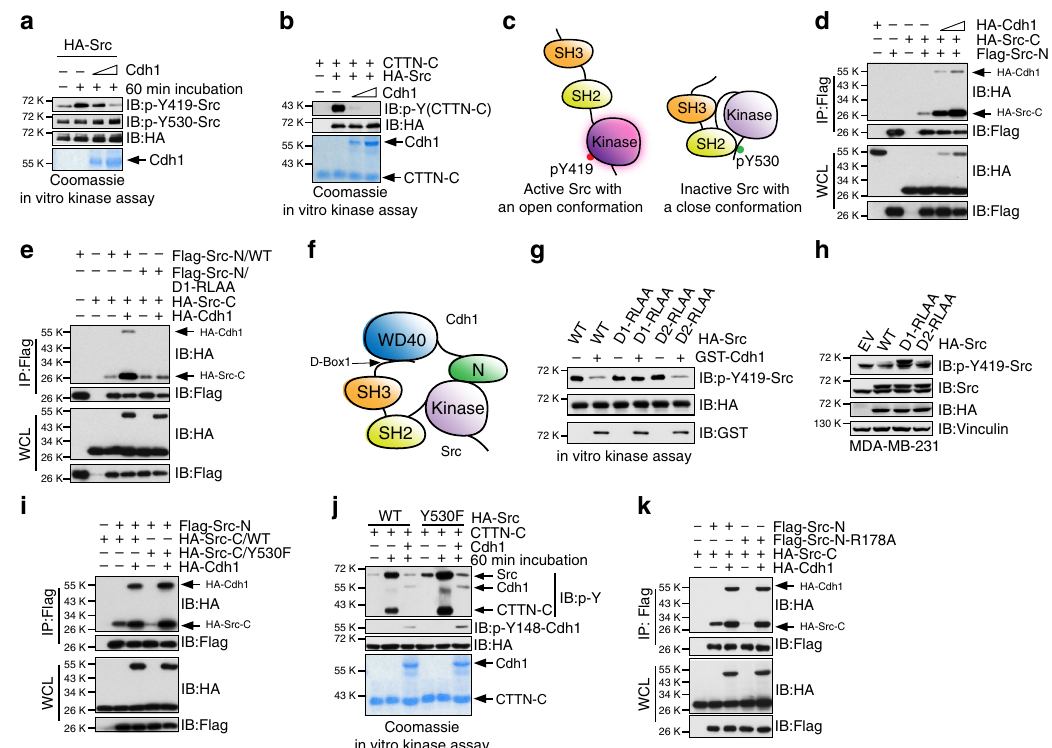
Fig. 4 Cdh1 suppresses Src kinase activity by locking Src in a closed conformation. a Immuno-puri fi ed HA-Src from 293T cells were incubated with bacterially puri fi ed and cleaved recombinant Cdh1 as indicated. The reaction was performed at 30 °C for 60 min followed by SDS-PAGE and Immunoblot (IB) analyses. b Recombinant Cdh1 inhibited the kinase activity of Src to promote the C-terminal domain of p85 cortactin (CTTN- C ) phosphorylation in vitro. c A schematic illustration of the open and closed conformations of the Src kinase. d IB analysis of whole-cell lysates (WCL) and immunoprecipitates (IP) derived from 293T cells transfected with HA-Cdh1 and the indicated Src constructs. e IB analysis of WCL and IP derived from 293T cells transfected with HA-Cdh1 and the indicated Src constructs. f A schematic illustration of how Cdh1 secures the closed, inhibitory conformation of Src by reinforcing the binding between N - and C - terminus of Src. g Immuno-puri fi ed HA-Src proteins from 293T cells were incubated with bacterially puri fi ed GST-Cdh1. The reaction was performed at 30 °C for 60 min and followed by SDS-PAGE and IB analyses. h IB analysis of WCL derived from MDA- MB-231 cells transfected with EV, WT, D-box1-mutated, and D-box2-mutated HA-Src as indicated. Cells were harvested 48 h after transfection. i IB analysis of WCL and IP derived from 293T cells transfected with HA-Cdh1 and the indicated Src constructs. j Immuno-puri fi ed WT and Y530F-HA-Src from 293T cells were incubated with bacterially puri fi ed Cdh1 and CTTN- C . The reaction was performed at 30 °C for 60 min and followed by SDS-PAGE and IB analyses. k IB analysis of WCL and IP derived from 293T cells transfected with HA-Cdh1 and the indicated Src